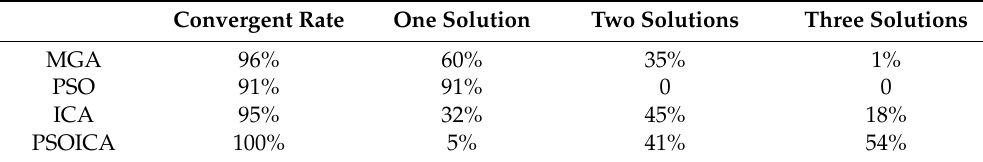
Table 5. Comparing the results of four switching angles.